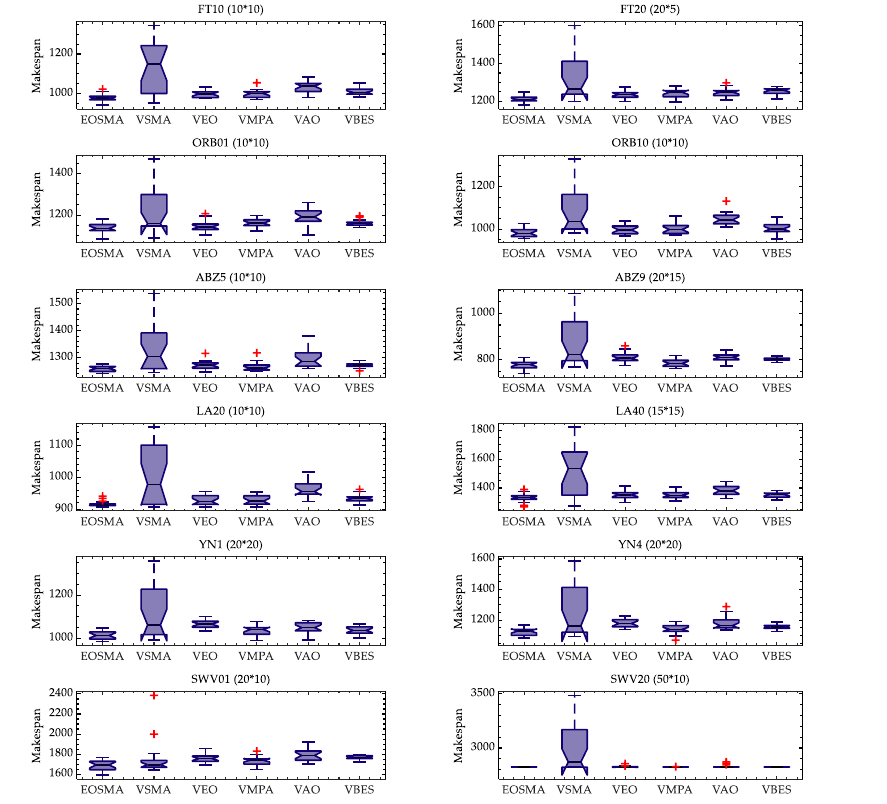
Figure 8. Box plots of all algorithms executed 20 times on instances. Table 8. The p -value generated by Wilcoxon rank-sum test